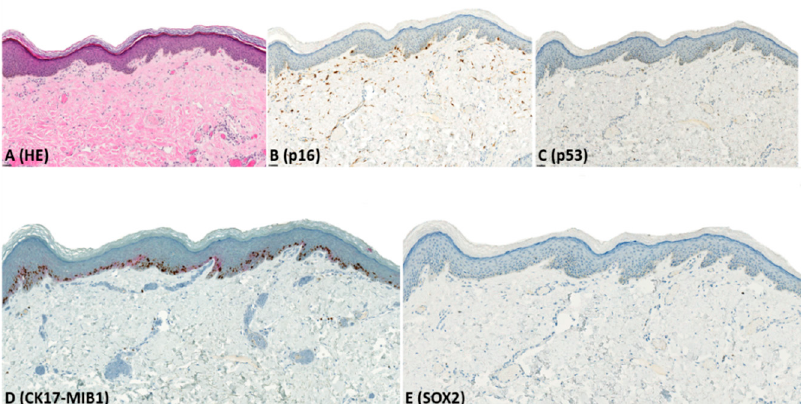
Figure 1. Example of immunohistochemical expression of p16, p53, CK17, MIB1, and SOX2 in lichen sclerosus (LS); ( A ) Histological appearance of LS (hematoxylin-eosin (HE) stain); ( B ) complete lack of p16-expression; ( C ) wild-type (scattered) p53-expression; ( D ) focal, weak, CK17-expression and increased MIB1 expression; ( E ) complete lack of SOX2-expression.